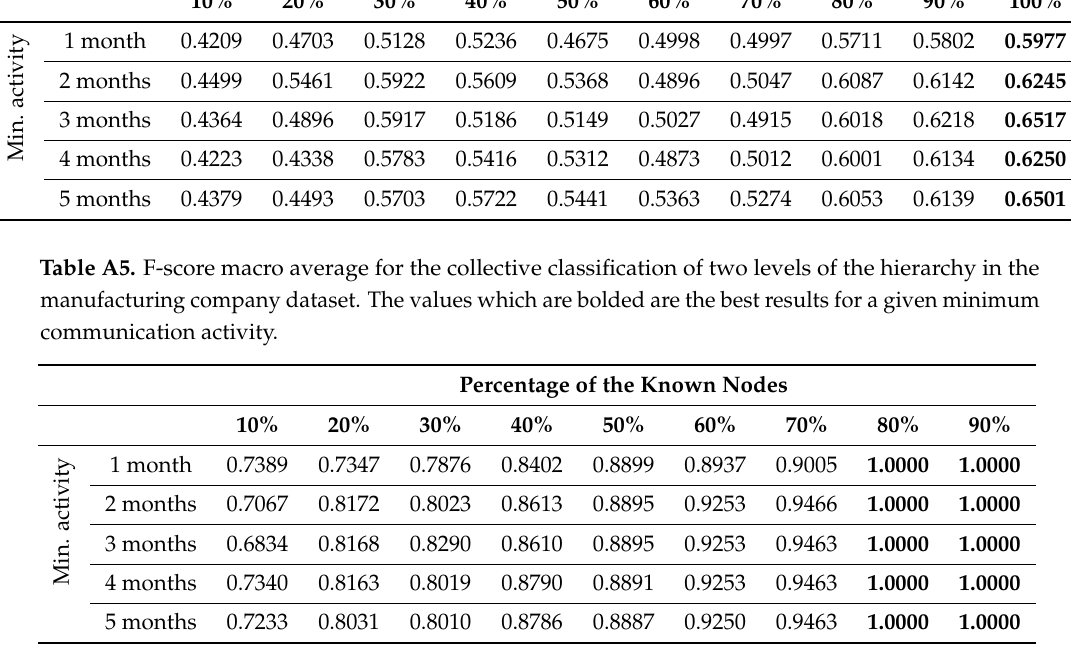
Table A6. F-score macro average for the Decision Tree classification of three levels of the hierarchy in the manufacturing company dataset. The values which are bolded are the best results for a given minimum communication activity.